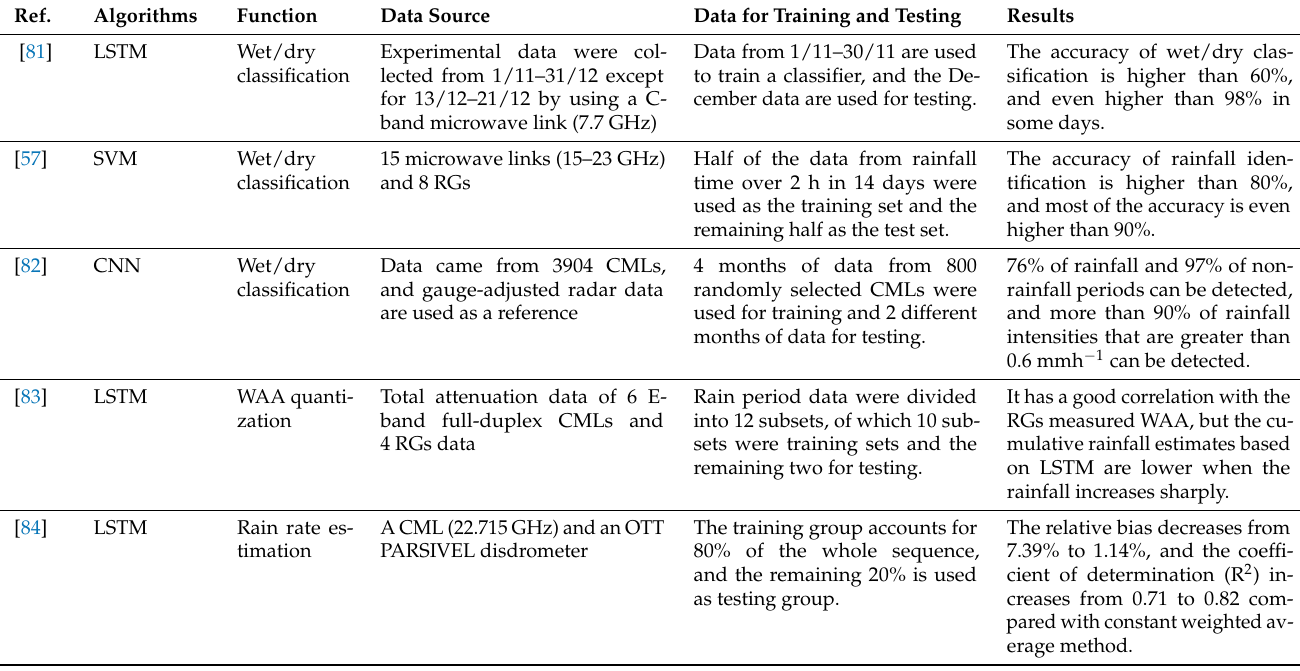
Table 3. Machine learning algorithms applied in CML-based rainfall